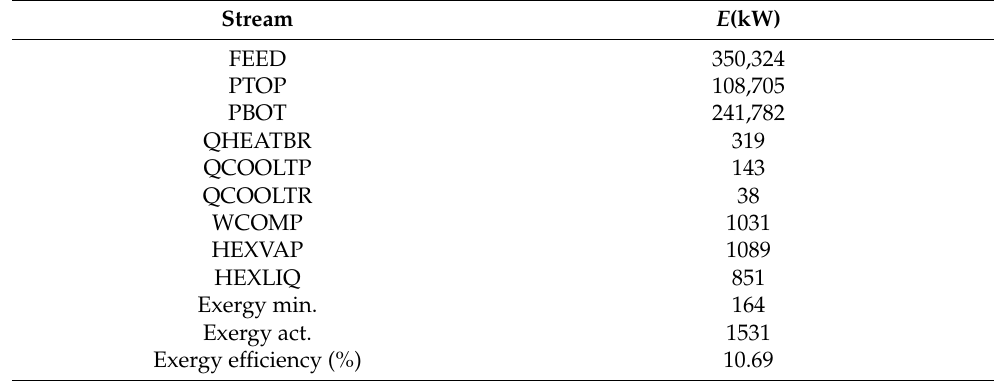
Table 7. Exergy analysis of the modified VRC system.